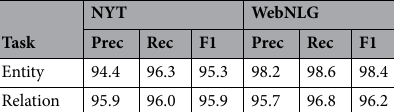
Table 4. Performance of our model for two tasks of entity extraction and relation extraction on two datasets.